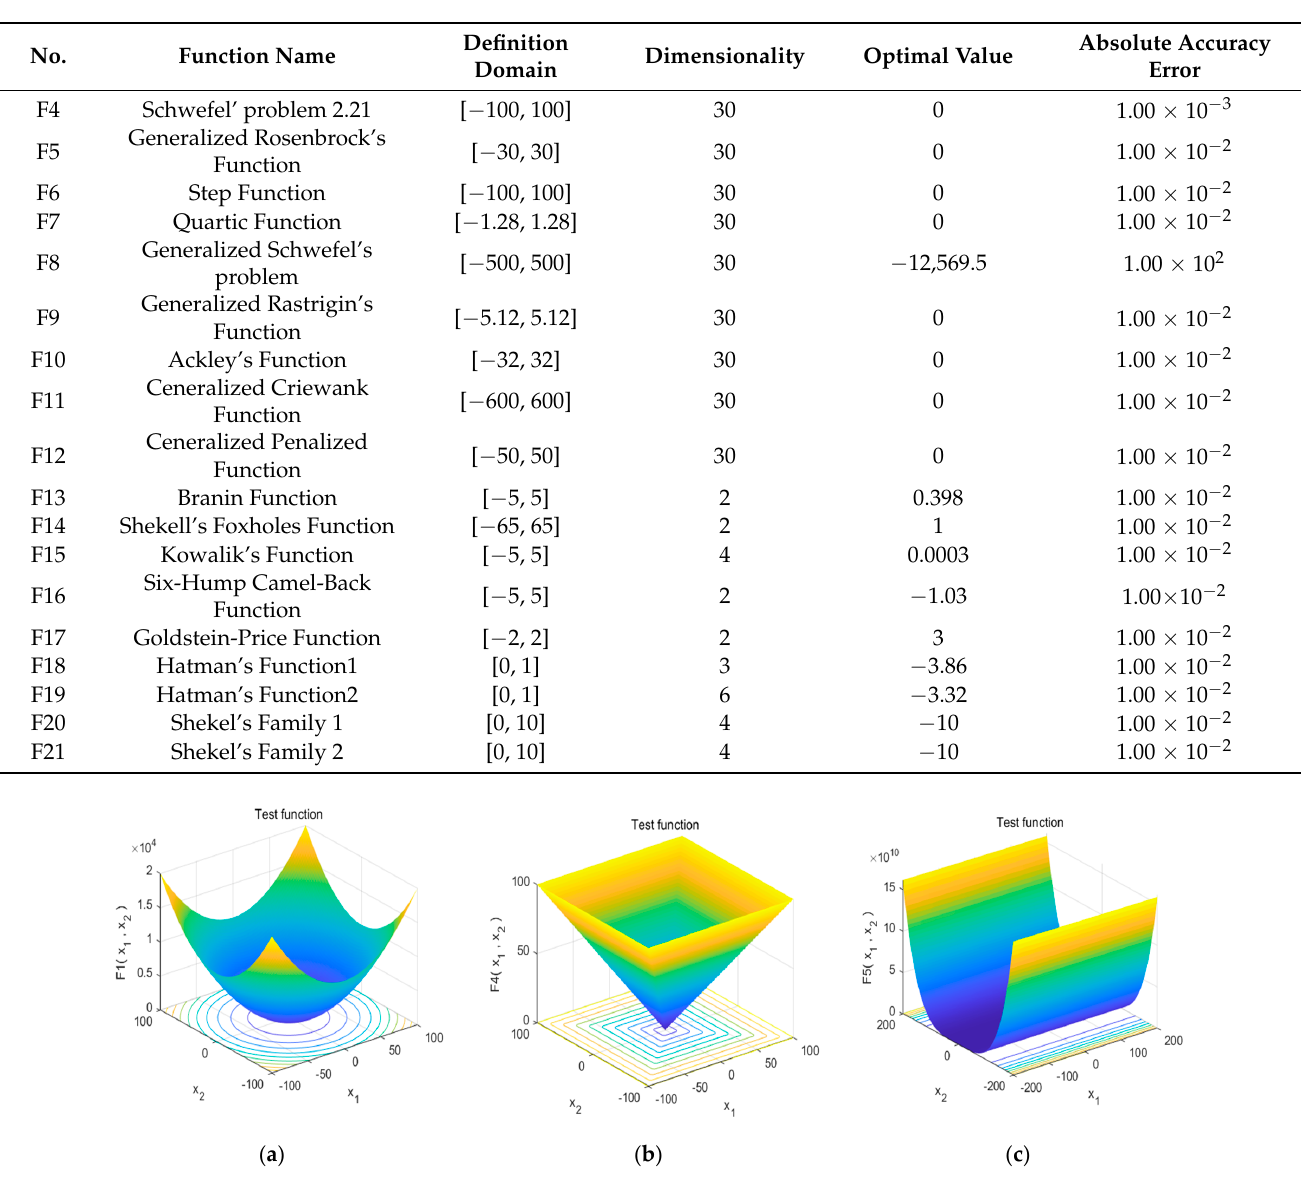
Figure 7. Distribution diagram of different continuous unimodal test function values. ( a ) F1 function; ( b ) F4 function; ( c ) F5 function.